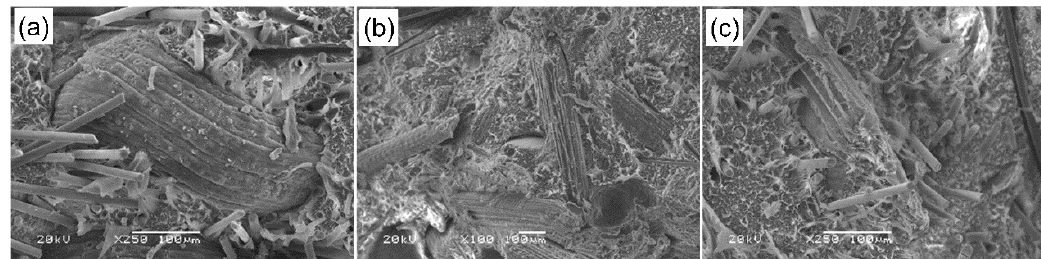
Figure 6. SEM images of hybrid composites with 12%wt. fiber content ( a ) PE with basalt fibers and coconut fibers, ( b ) PE with coconut fibers and wood flour, ( c ) PE with basalt fibers and wood flour.